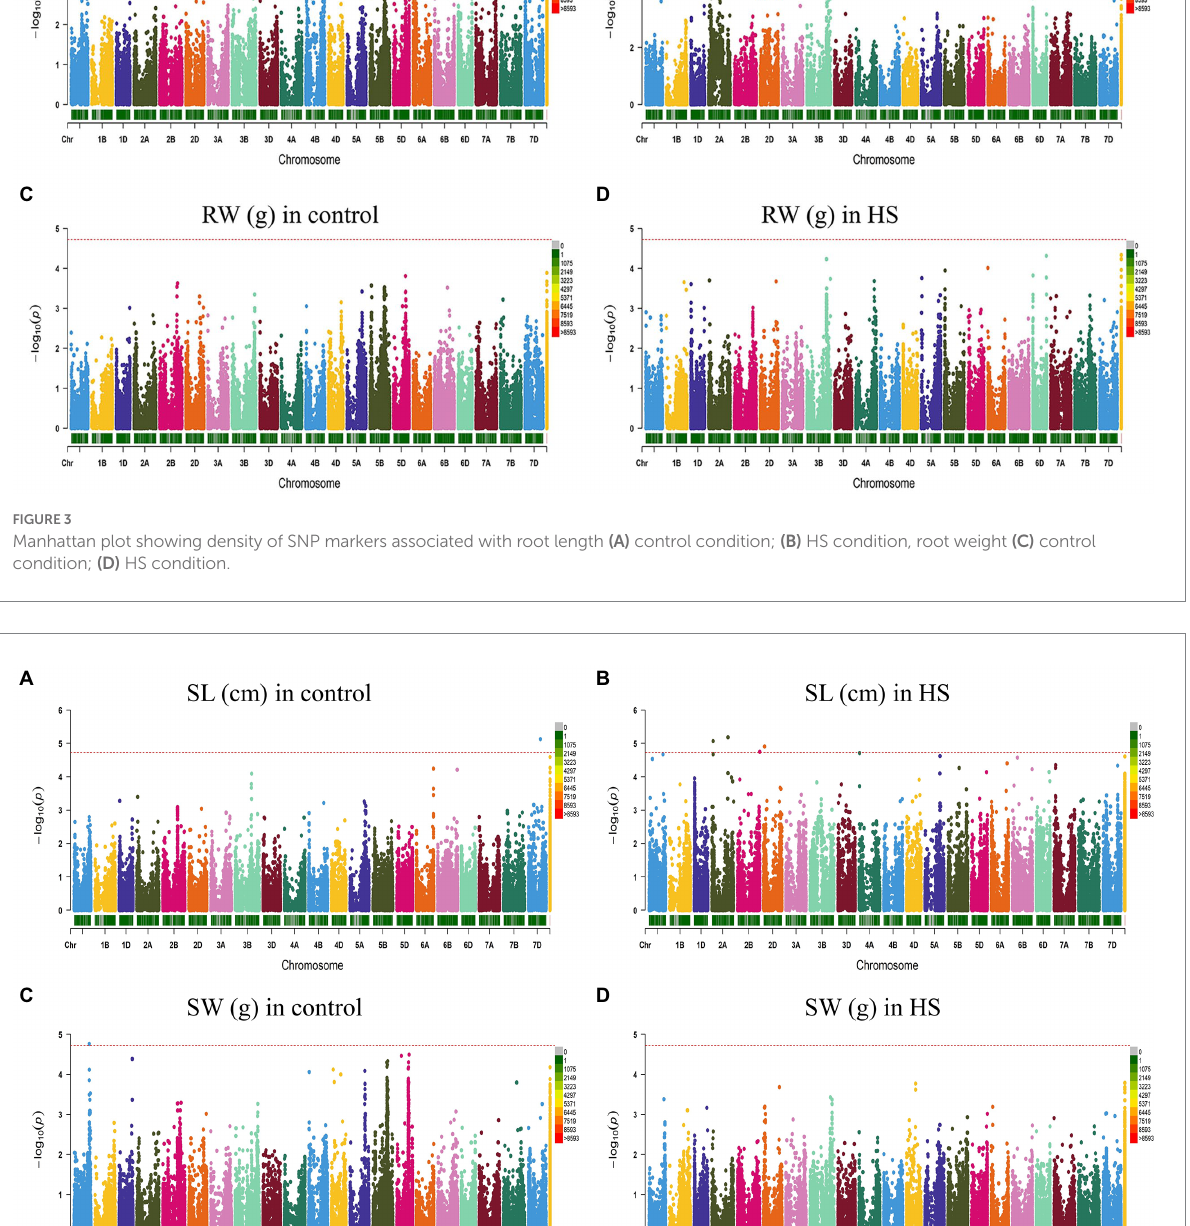
0.31 Mb close to HSP in upstream region. The same QTN was 0.65 Mb away from another HSP in upstream region. Another QTN for RW (AX-111026550) on chr3B was present between